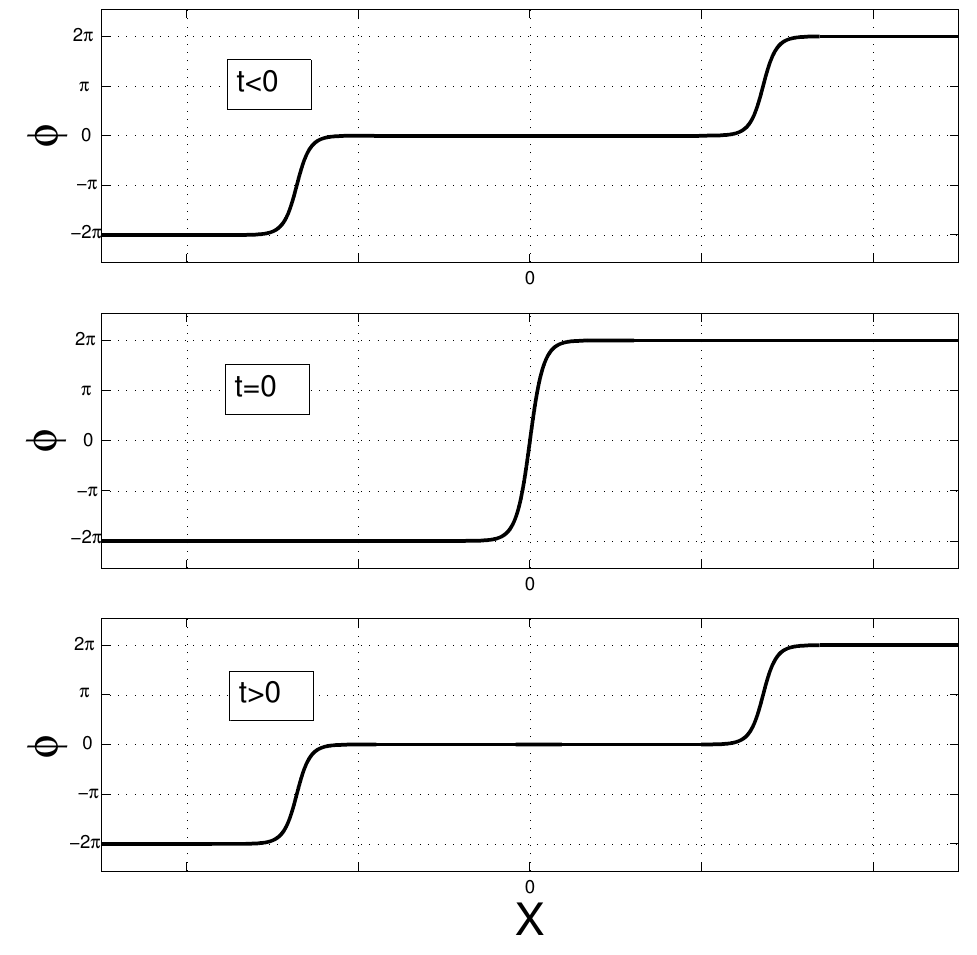
Figure 3. The two-soliton solution of the Sine–Gordon